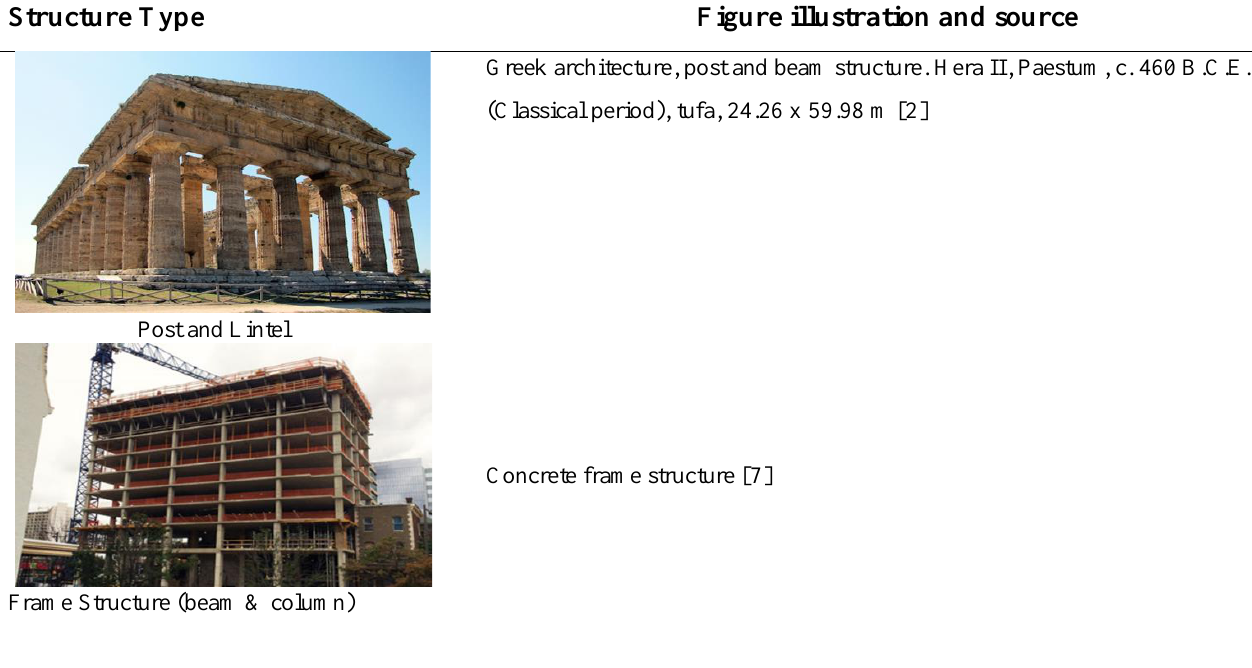
Table 1. Types of structure in architecture Structure Type Figure illustration and